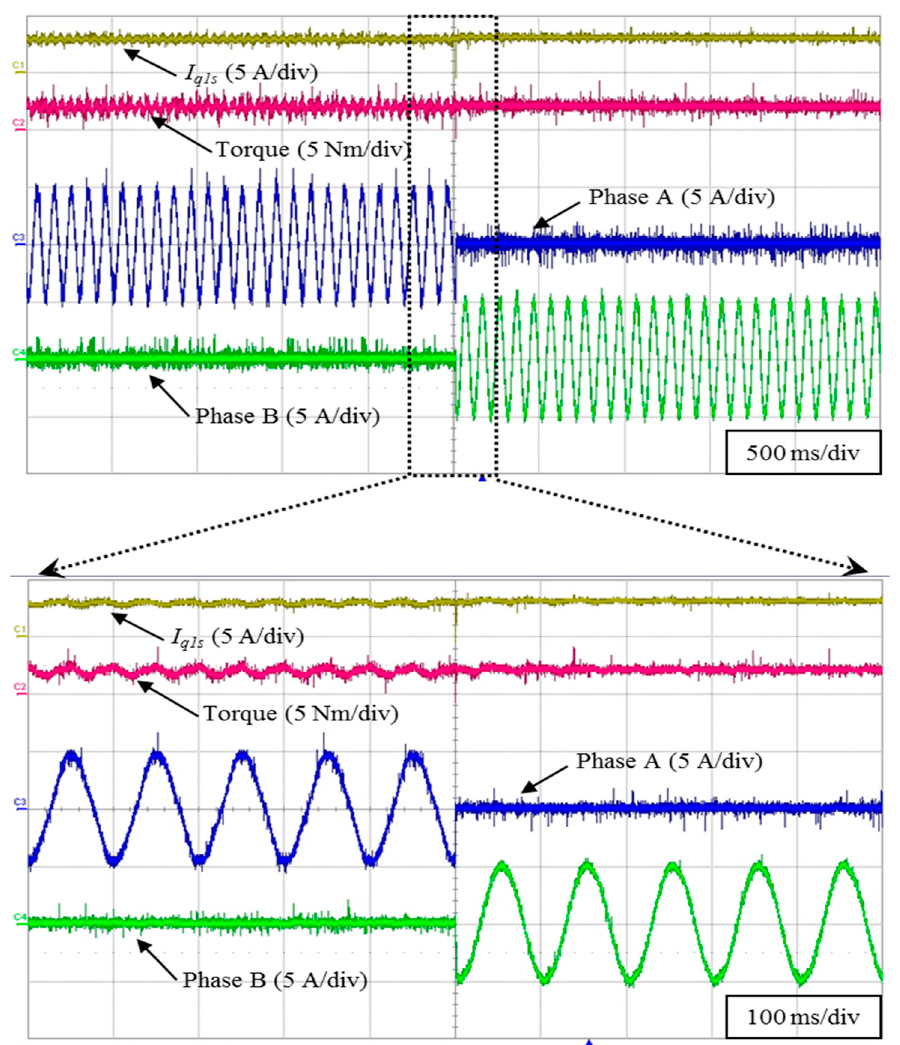
Figure 20. Phase B open fault and applying proposed fault ‐ tolerant control for phase B.